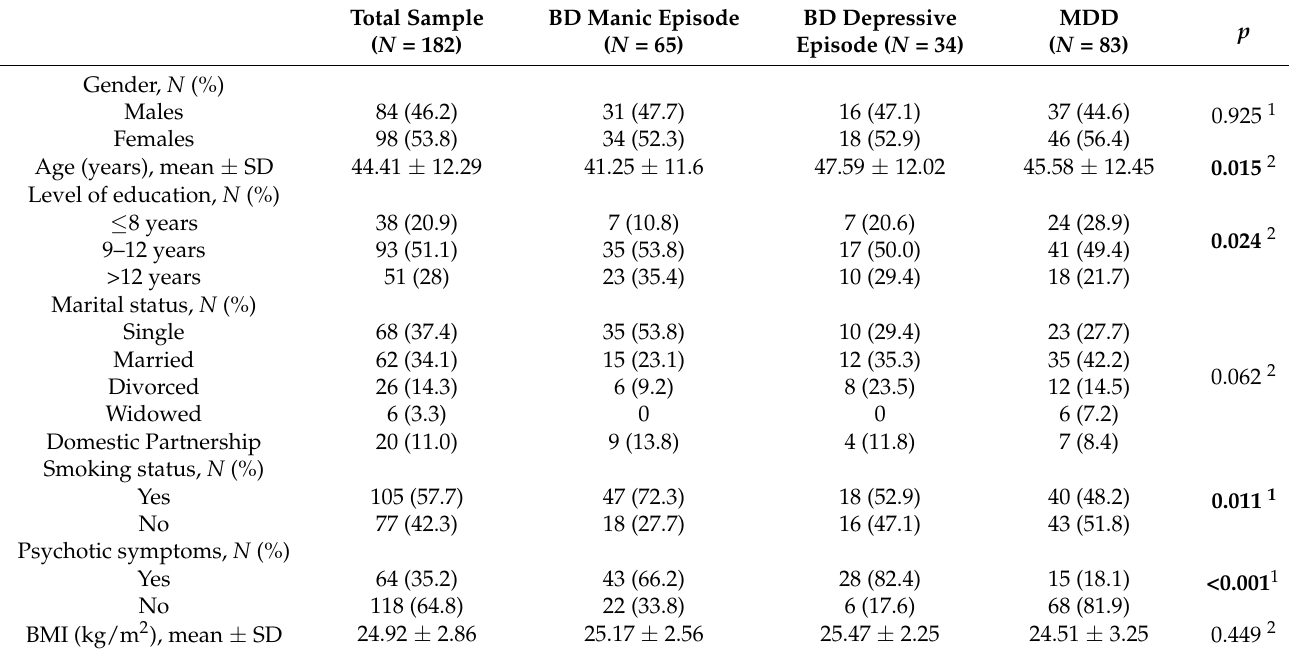
Table 1. Socio-demographic and clinical characteristics of the